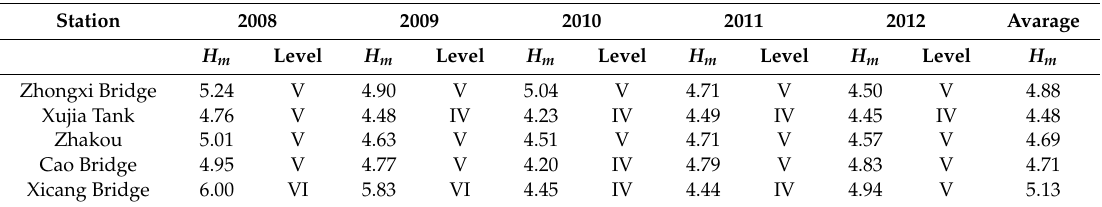
Table 3. Grade characteristic values and river water quality level from 2008 to 2010 for five stations along the Caoqiao